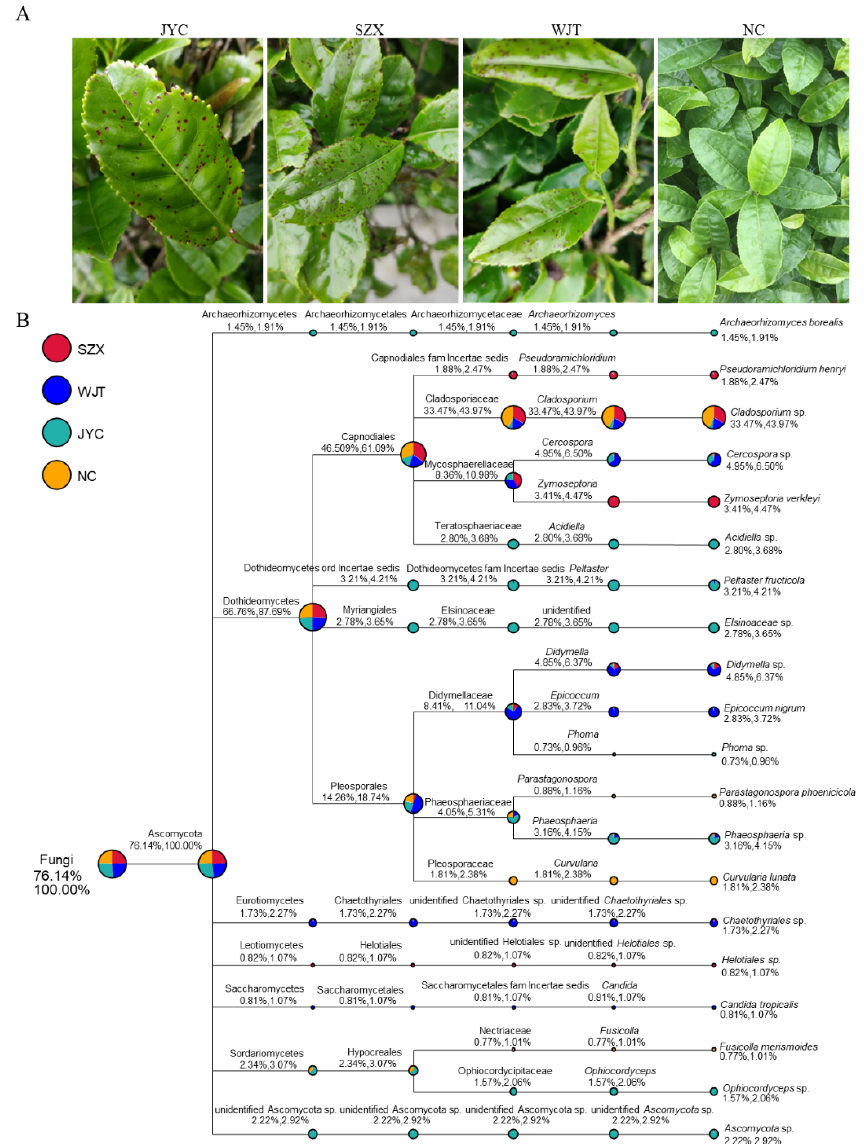
Figure 1. Sample symptoms and phylogenetic tree of Ascomycota fungi revealed by amplicon sequencing in samples SZX, WJT, JYC, and NC in the diverse taxonomic situation. ( A ) The symptoms of the collected tea leaves showing brown-black spot disease (LBSD) collected from three different regions. ( B ) The phylogenetic tree for twenty fungal species with leading relative abundance in each sample selected and involved in the analysis. The circles with different colors on the upper-left position refer to the diverse samples; the circles in different nodes indicate different taxonomic levels, with varied colors and sizes referring to the composition and relative abundance, respectively. The two numbers below the category name represent the proportion of their relative abundance accounting for all the fungal categories and Ascomycota, respectively.